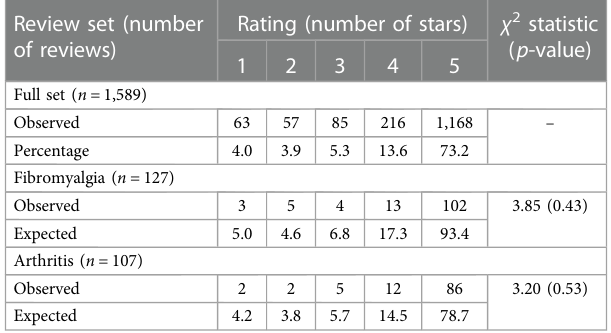
TABLE 2 Χ 2 tests for disorder-speci fi c rating distribution against that of the entire